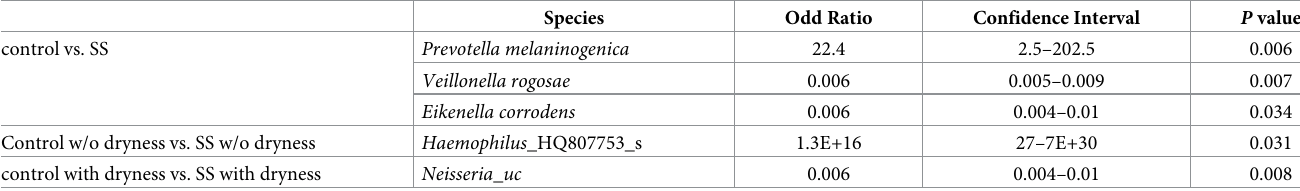
Table 5. Species associated with SS in combined, non-dry, and dry conditions identified by logistic regression